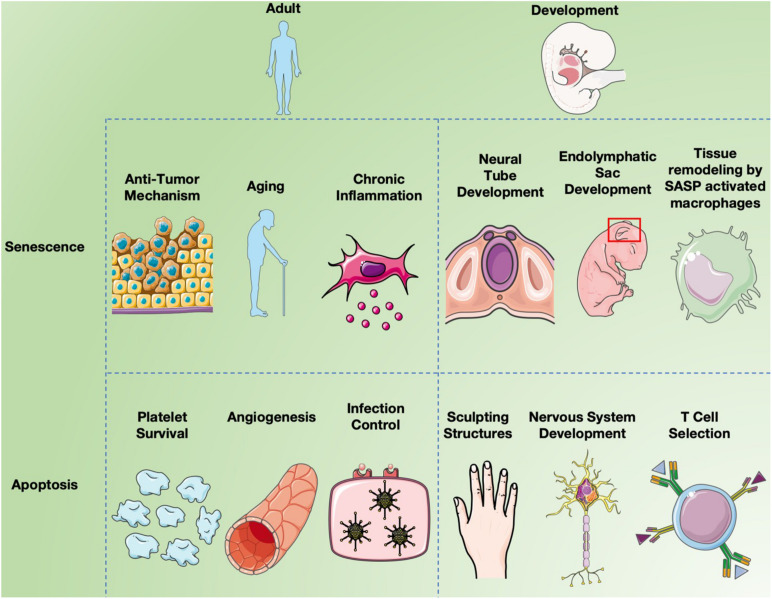
Senescence and apoptosis in development and aging. Cell senescence is clearly a major factor in inducing chronic inflammation by fragmented DNA activating the innate immune response via cGAS- STING, resulting in senescent cells secreting a combination of factors collectively called the SASP (Hopfner and Hornung, 2020). Inflammation induces many aspects of aging, but cell senescence is also believed to serve as a “first line of defense” against cancer since it limits cell replication (Campisi, 2003). While apoptosis long been known to affect different aspects of both development and aging, recent studies have implicated programmed cell senescence in tissue remodeling of different types (Muñoz-Espín et al., 2013; Storer et al., 2013; Zhao et al., 2018).